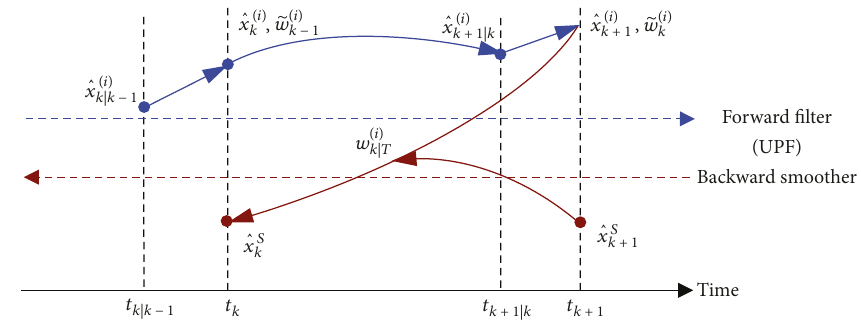
Figure 1: The principle diagram of